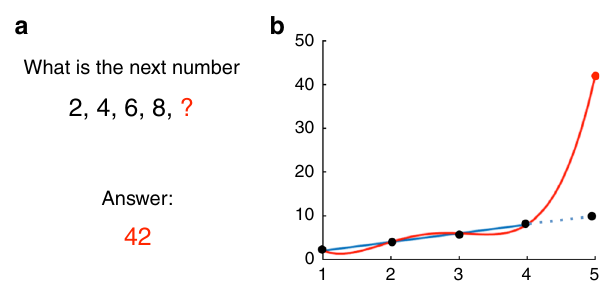
Fig. 1 The “ bias-variance tradeoff ” in machine learning can be seen as a formalization of Occam ’ s Razor. a As an example of the bias-variance tradeoff and the risks of over fi tting, consider the following puzzle: Find the next point in the sequence {2, 4, 6, 8, ?}. Although the natural answer may seem to be 10, a fi tting function consisting of polynomials of degree 4 — a function with fi ve free parameters — might very well predict that the answer is 42. b The reason is that in general, it takes two points to fi t a line, and k þ 1 points to fi t the coef fi cients c f ð x Þ ¼ c þ c x þ (cid:2)(cid:2)(cid:2) þ i of a polynomial 0 1 c x k of degree k . Since we only have data for four points, the next entry k could be literally any number (e.g., red curve). To get the expected answer, 10, we might restrict the fi tting functions to something simpler, like lines, by discouraging the inclusion of higher order terms in the polynomial (blue